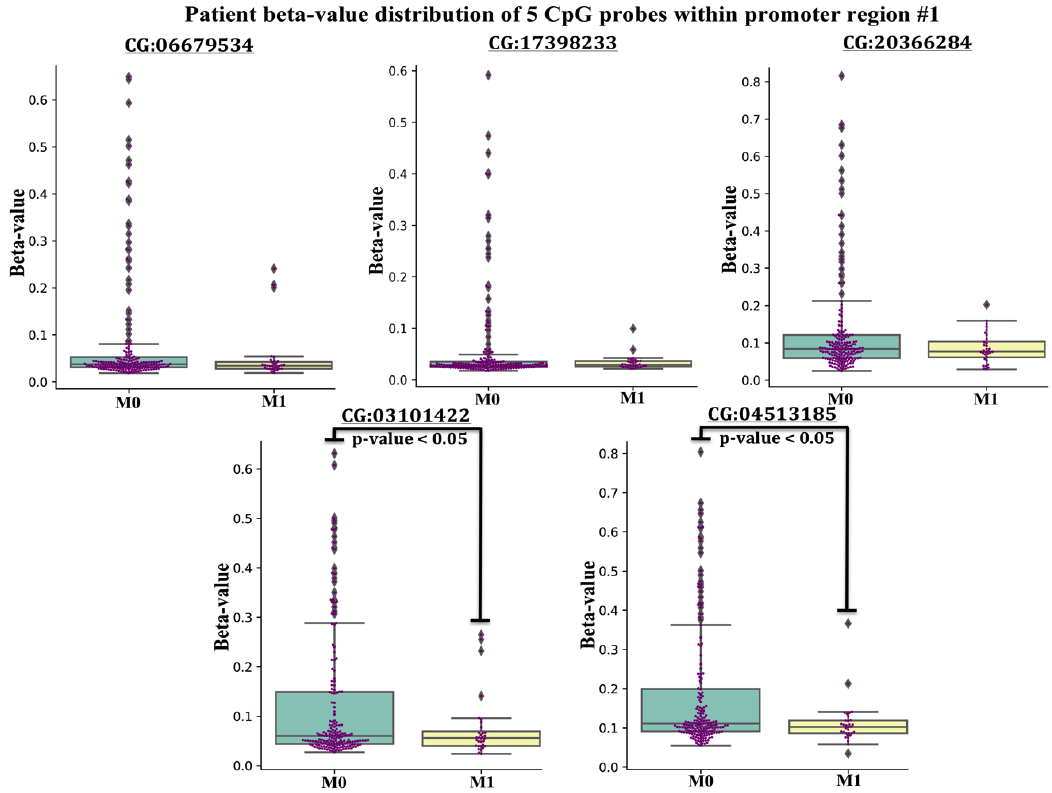
Figure 3. 5 Boxplots displaying methylation beta-values (Y-axis) of 5 probes within promoter CpG island region #1, extracted from CRC patients classified in the Tumor, Node, Metastasis (TNM) staging system as M1 = evidence of metastasis and M0 = no evidence of metastasis from the TCGA registry. The [CG########] ID on the X-axis of each boxplot represents the unique ID of each probe within the 450K-array data set. A student t -test was conducted in finding mean beta-value di ff erences for two CG probes between M0 and M1 cohorts ( p -value <